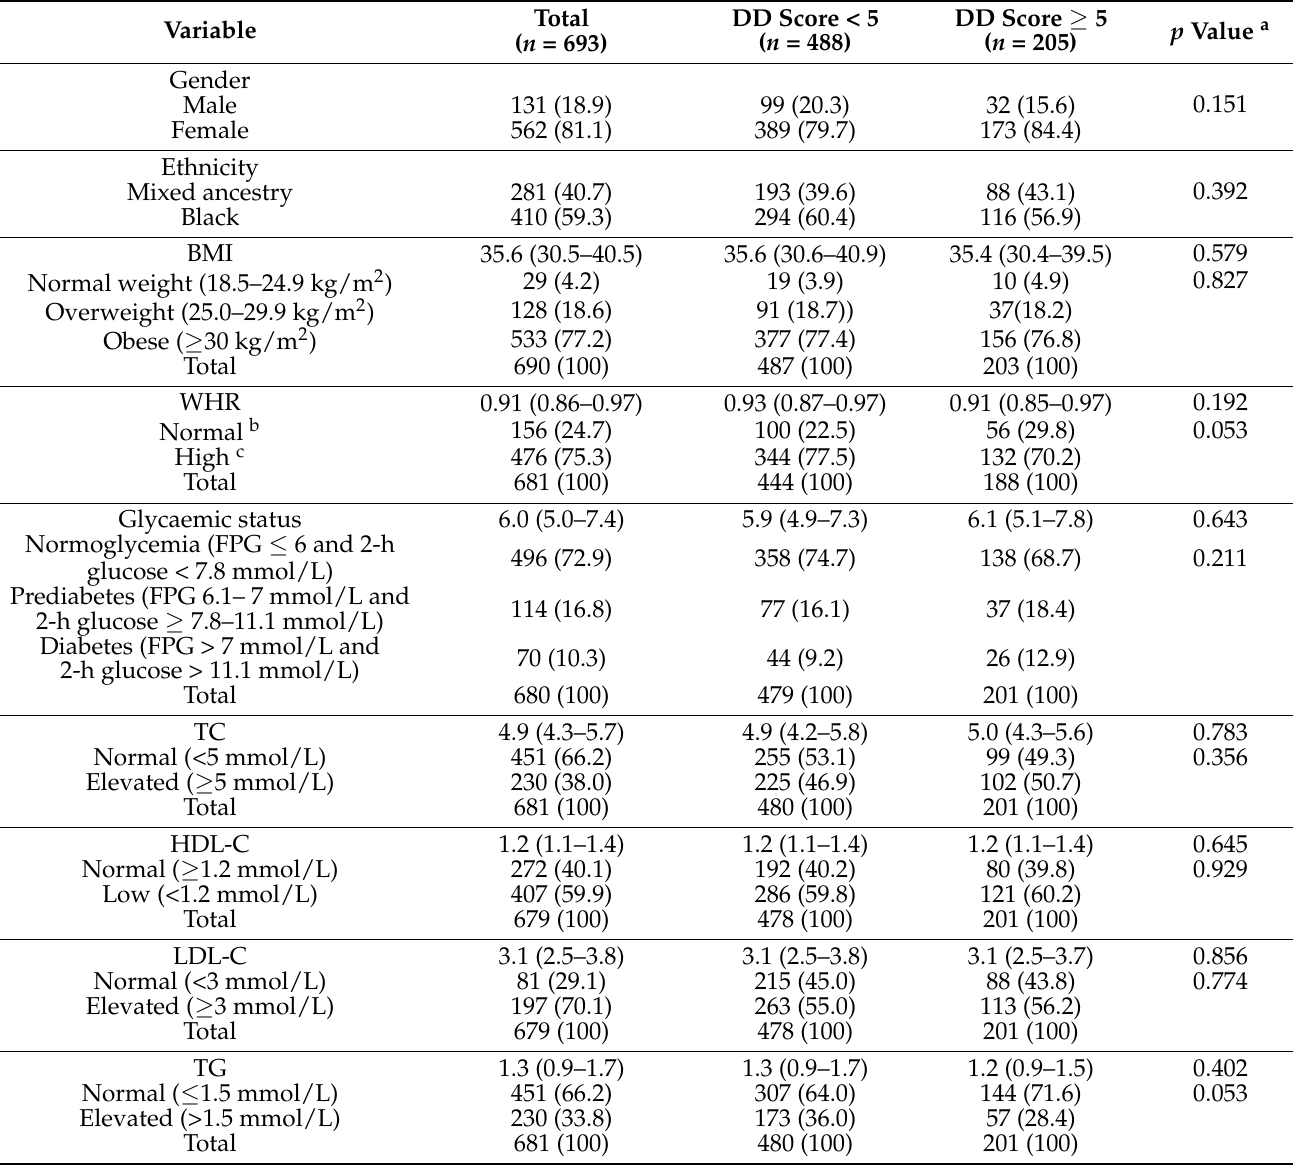
Table 3. Nutritional status and cardiometabolic risk factors for the total study sample and the two dietary diversity categories respectively.